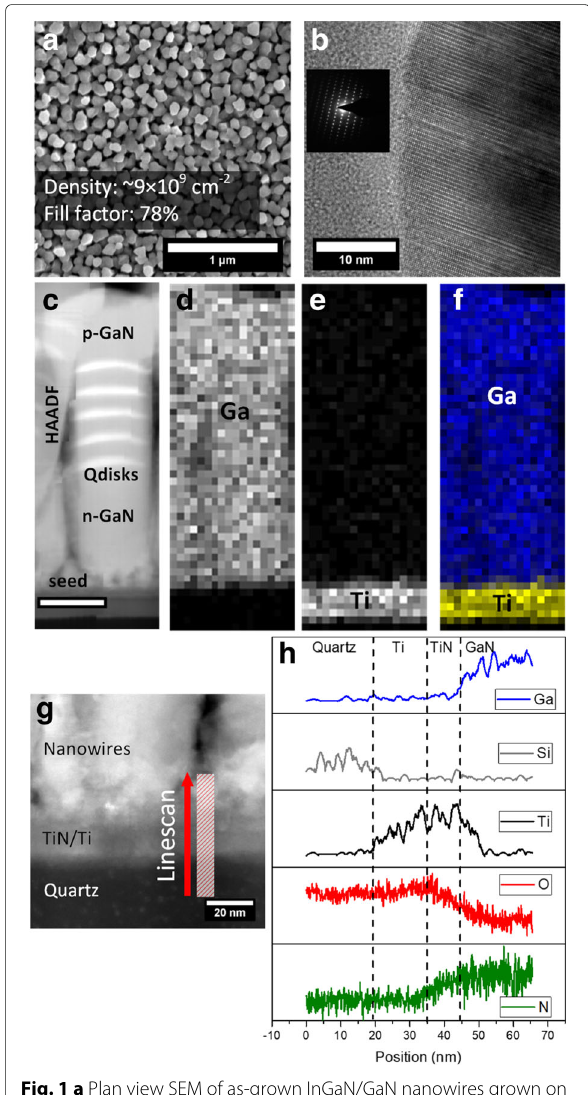
Fig. 1 a Plan view SEM of as-grown InGaN/GaN nanowires grown on quartz. b High-magnification view of bright field TEM from the p-GaN region, showing the crystallinity of the nanowire. Inset shows the selective area electron diffraction pattern taken from the nanowire. c HAADF image of a single nanowire and d corresponding EDX map for Ga, e Ti, and f composite elemental mapping . Scale bar corresponds to 25 nm. g High-magnification view of the interface between the nanowire base, interlayer, and substrate. Red arrow indicates the direction for the elemental mapping. h Corresponding EDX and EELS results showing the change in elemental composition across the material interfaces. The EDX results are smoothed to remove noise